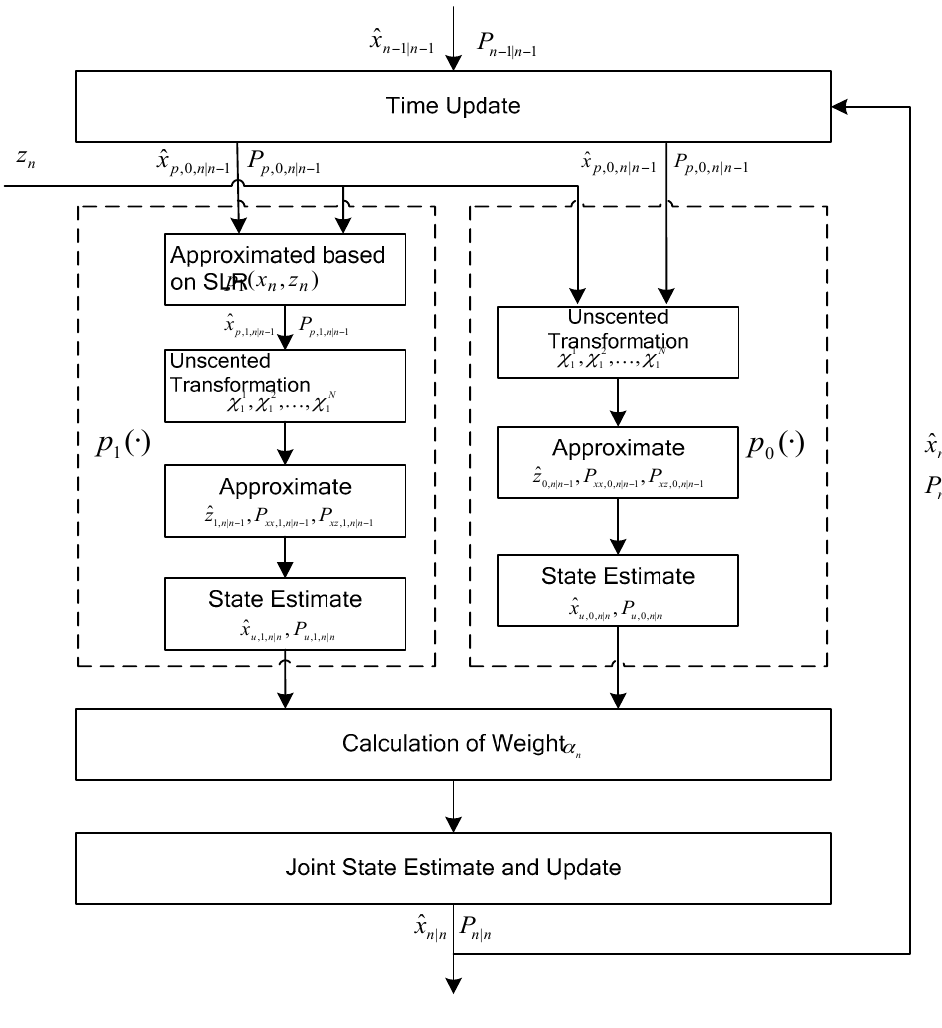
Figure 1. Auxiliary truncated unscented Kalman filtering. Algorithm: Auxiliary Truncated Unscented Kalman Filtering (ATUKF) ATUKF—Update based on the prior probability density function (PDF) p 0 ( ·